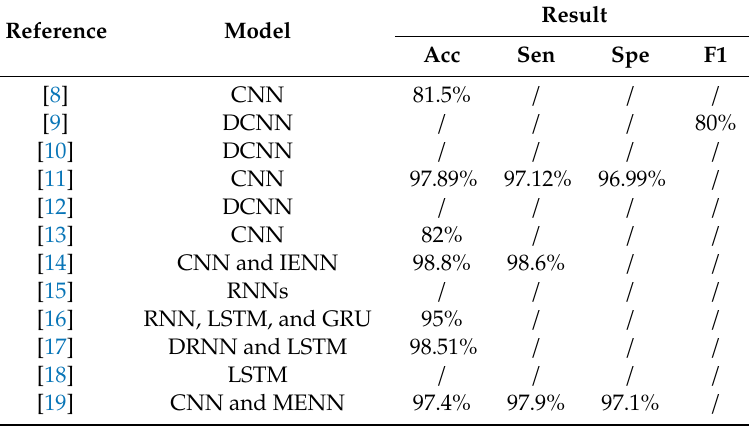
Table 1. Models and results in